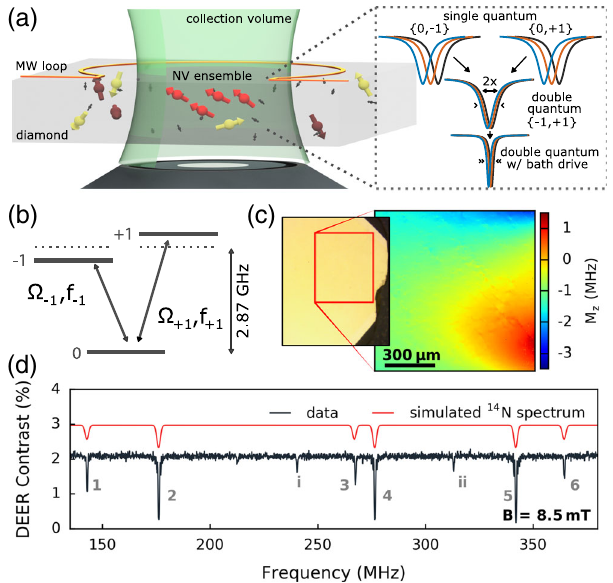
FIG. 1. NV ensemble spectroscopy of diamond spin bath. (a) The inhomogeneously broadened electron spin resonance (ESR) linewidth of NV ensembles is a complex function of the local environment within the diamond sample, which includes a diverse bath of electronic and nuclear spins. Inset: Schematics of NV ensemble ESR spectra in the single quantum and double quantum bases, and for double quantum with spin-bath drive. (b) Spin-1 ground state of the NV center. (c) Imaging of the longitudinal strain component M z of one NV orientation class across a 1 -mm 2 field of view for sample B. An optical microscope image of the diamond surface (left) is included for reference with a red box outlining the field of view shown in the NV strain image. (d) NV double electron-electron resonance (DEER) spectrum of sample B, showing six nitrogen groups (1 – 6) attributed to 14 N electronic spins with an external field B 0 ¼ 8 . 5 mT aligned along a [111]-crystallographic axis (see main text). Linewidths are Fourier broadened. The peaks labeled i and ii correspond to dipole-forbidden transitions of the 14 N electronic spins ( Δ m I ≠ 0 ; see Supplemental Material Sec. XI [28]). The simulated spectrum using the full nitrogen Hamiltonian is shown in red, with linewidth and amplitudes chosen to reflect the experimental